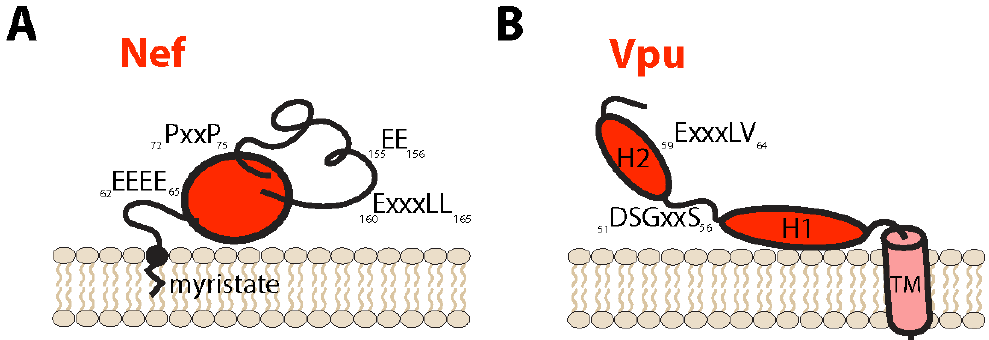
Figure 1. Structure of human immunodeficiency virus type I (HIV-1) negative factor (Nef) protein and viral protein U (Vpu). ( A ) HIV-1 Nef is a soluble protein found associated with cellular membranes through a myristate moiety added post-translationally to a glycine residue at amino acid (aa) position 2. Nef is composed of a compact globular core region (aa 58–149, 181–206) a flexible N ‐ terminus (aa 1–57) and a C ‐ terminal loop (aa 150–180). Conserved motifs of Nef include